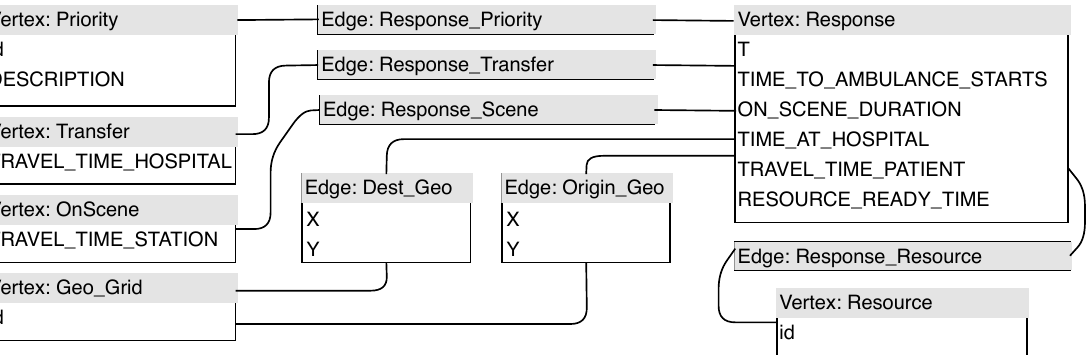
Figure A6. A UML diagram of the graph design of the simulation dataset in